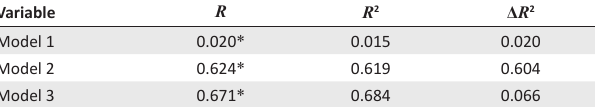
TABLE 3: Results of hierarchical